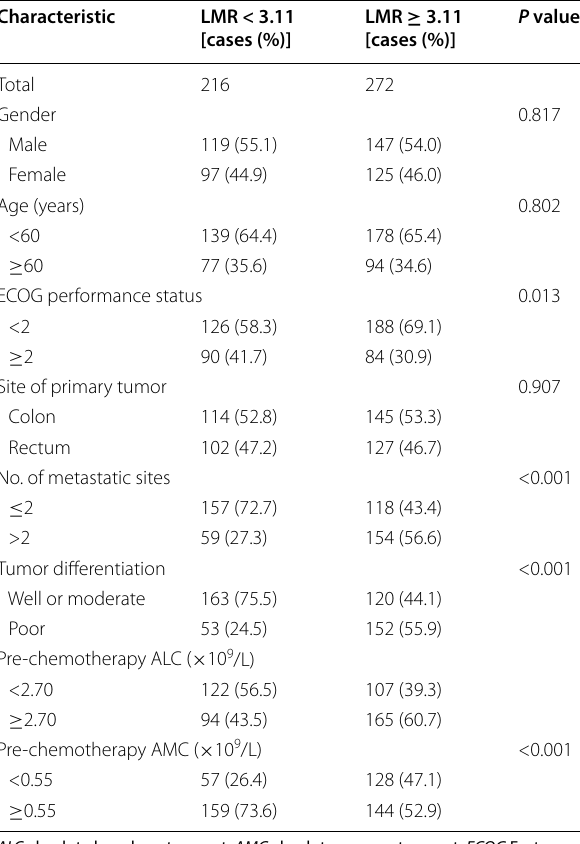
Table 1 Comparison of baseline clinical characteristics of patients with newly diagnosed metastatic